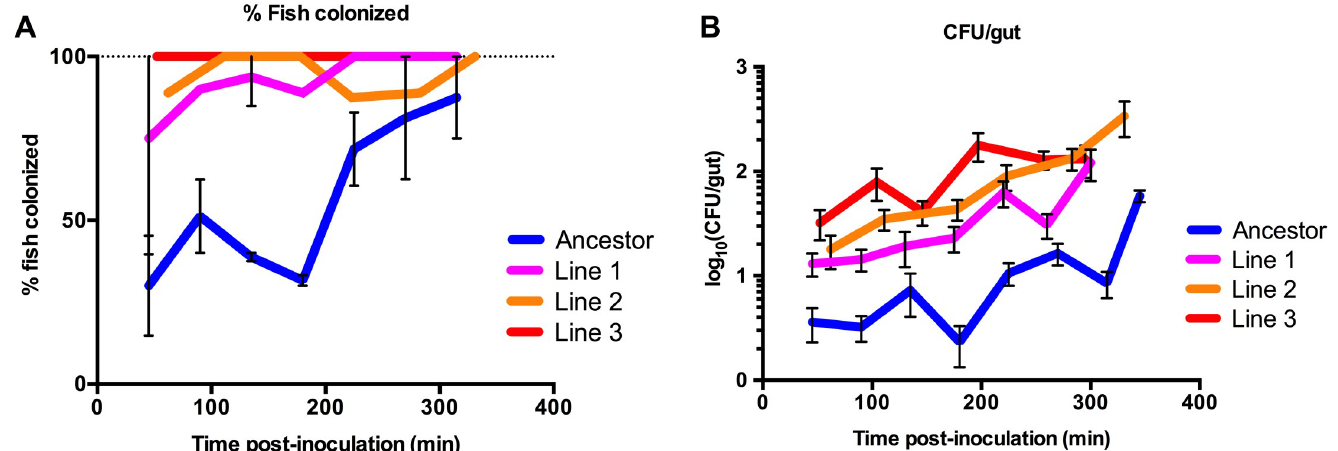
Fig 4. Evolved isolates demonstrate increased immigration into zebrafish hosts. (A) Groups of mono-associated fish were dissected and plated approximately every 45 minutes, and the fraction of colonized hosts was determined ( n = 8–10 fish per time point). A higher proportion of fish were colonized at earlier time points for the evolved isolates compared to the ancestor. Means ( ± SEM) are plotted for ancestor and line 1. (B) CFU/gut data (mean ± SEM) from the same samples presented in A show higher gut abundance for the evolved isolates at all time points. Data combined from three (ancestor), two (evolved, line 1), or one (evolved, lines 2 and 3) independent experiments. Underlying data for A–B are provided in S1 Data. CFU/gut, colony-forming unit per gut.